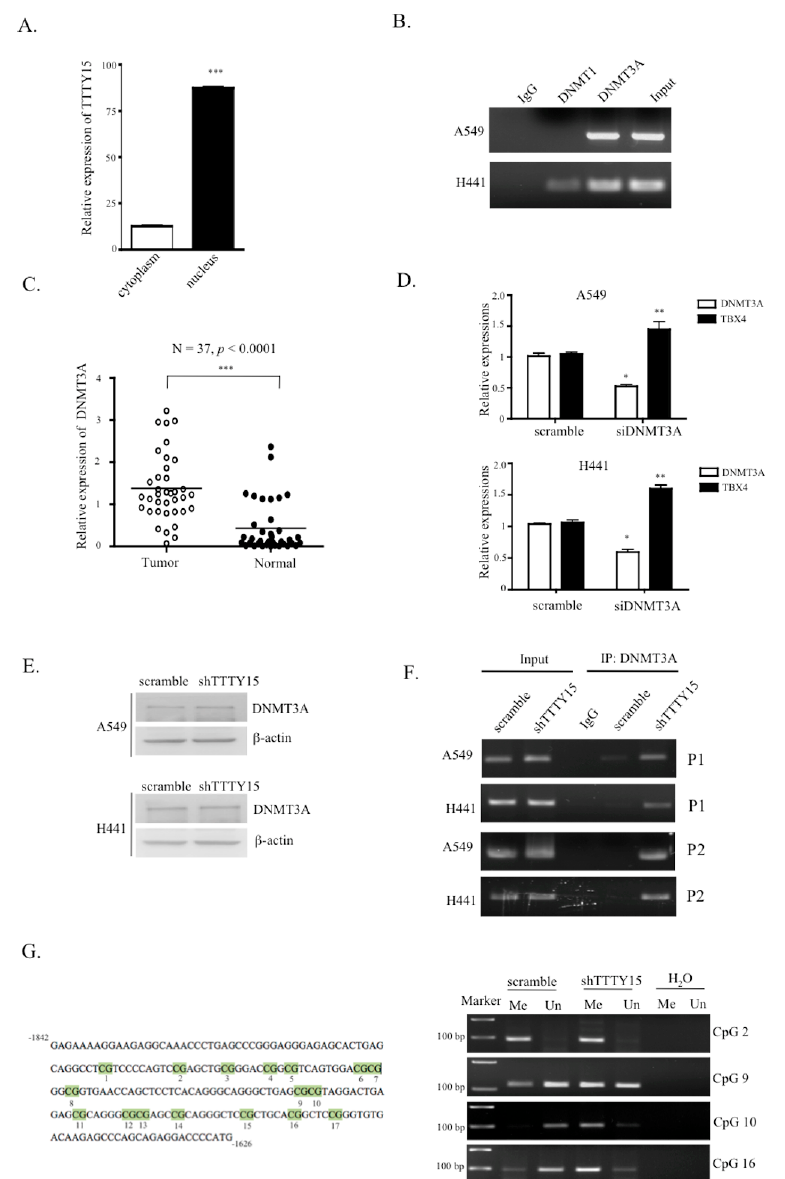
Figure 6. TTTY15 interacts with DNA methyltransferases (DNMT) 3A and decreases the binding of DNMT3A to the TBX4 promoter. ( A ) Cell fractionation assays were performed to determine the distribution of TTTY15 expression between the cell cytoplasm and nucleus. ( B ) TTTY15 RNA coimmunoprecipitated with DNMT1, DNMT3A, or IgG was quantified by qRT-PCR. PCR products were then loaded onto a 3% agarose gel for confirmation. ( C ) DNMT3A turned out to be upregulated in human NSCLC samples compared to the adjacent normal tissue samples (n = 37 for each group). ( D ) The knockdown of DNMT3A increased the expression levels of TBX4 in A549 and H441 cells. ( E ) The knockdown of TTTY15 did not affect the protein expression levels of DNMT3A. ( F ) Chromatin immunoprecipitation (ChIP)-qPCR was performed to quantify the binding of DNMT3A to the TBX4 promoter (P1: − 1734 to − 1626 bp; P2: − 740 to − 672 bp). ( G ) Methylation-specific PCR was performed to analyze the methylation status on the CpG islands of the TBX4 promoter in A549/scramble and A549/sh TTTY15 (Me: methylated; Un: unmethylated; H 2 O was used as a negative control). Data are presented as the mean ± SD; * p < 0.05, ** p < 0.01, *** p < 0.001. Statistical analysis was conducted by Student’s t -test ( n = 3).